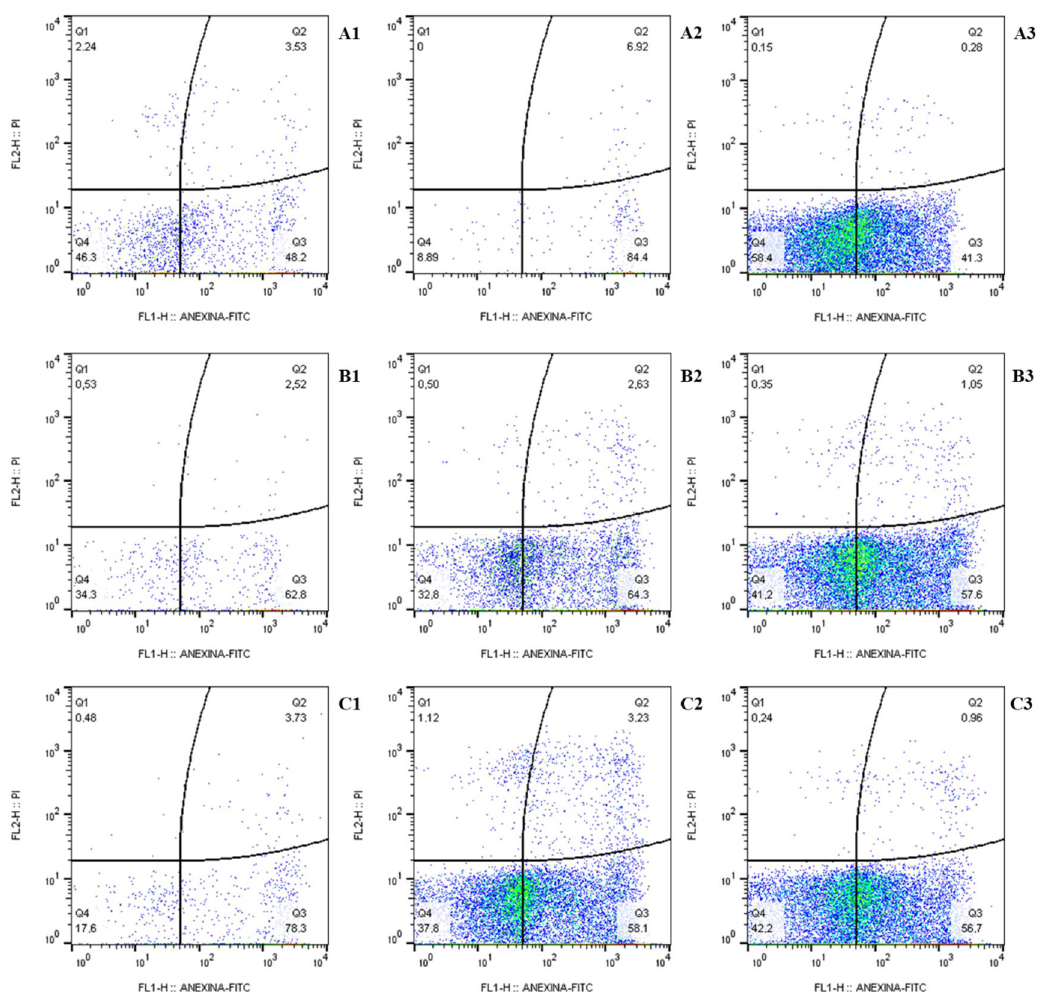
Figure 3. Flow cytometry for apoptosis analysis with Annexin V and propidium iodide in: ( A1 – A3 )